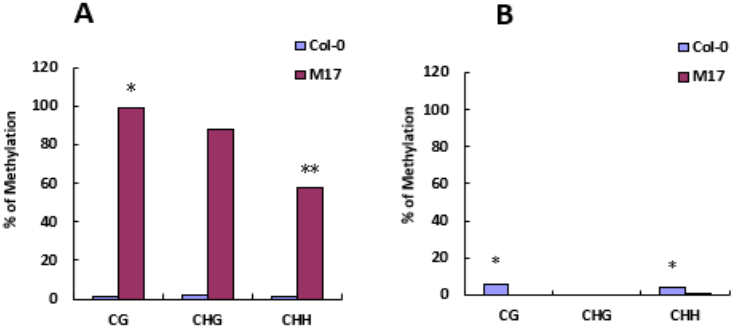
Figure 4. DNA methylation analysis of Col-0 and M17 by bisulfite sequencing. ( A ) DNA methylation analysis of AP3 promoter ( B ) DNA methylation analysis of PI promoter. The percentage of methylation on CG, CHG, and CHH sites are shown and T test analysis of methylation di ff erences in the group (* p < 0.05, ** p <